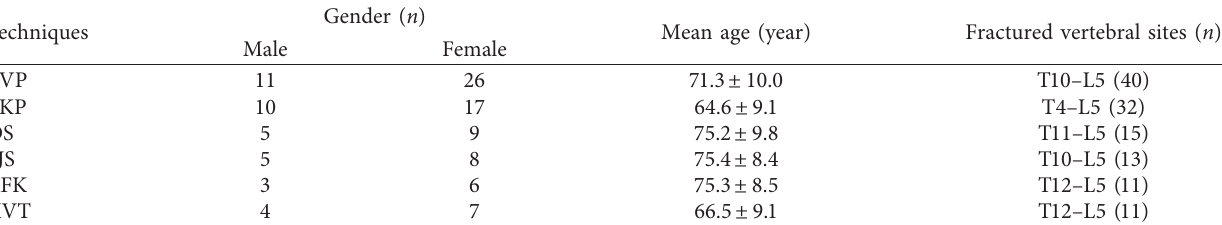
Table 2: Summary of study characteristics (population, gender, and etiology).